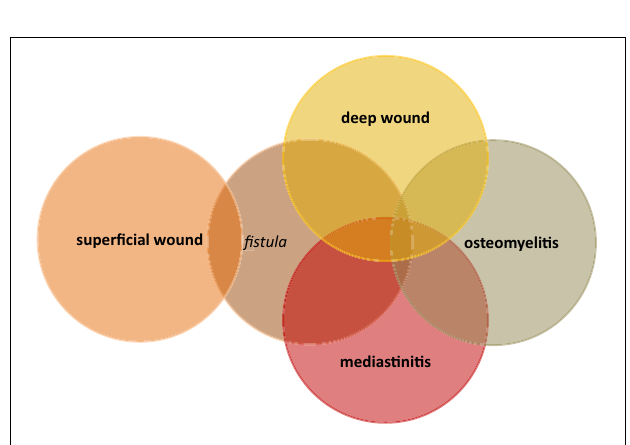
FIGURE 2 |Types and interactions of post-sternotomy wound infections